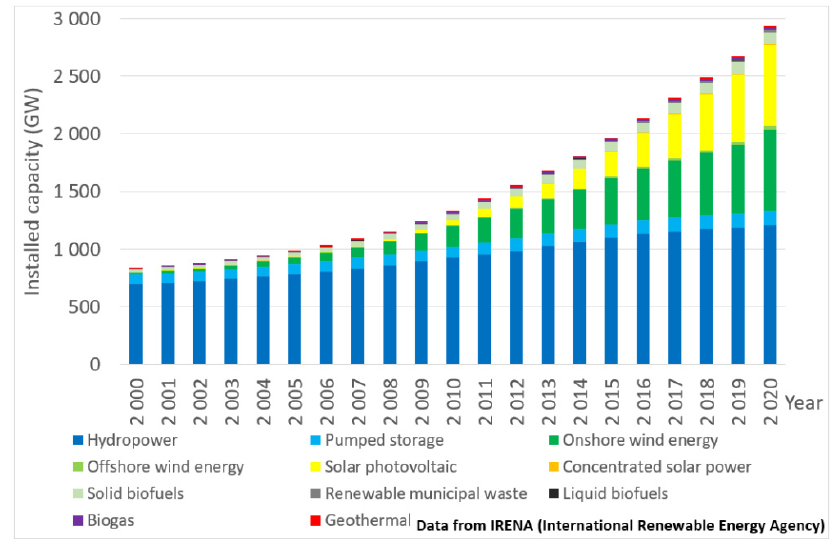
Figure 1. Global installed renewable energy capacity trend [14] .